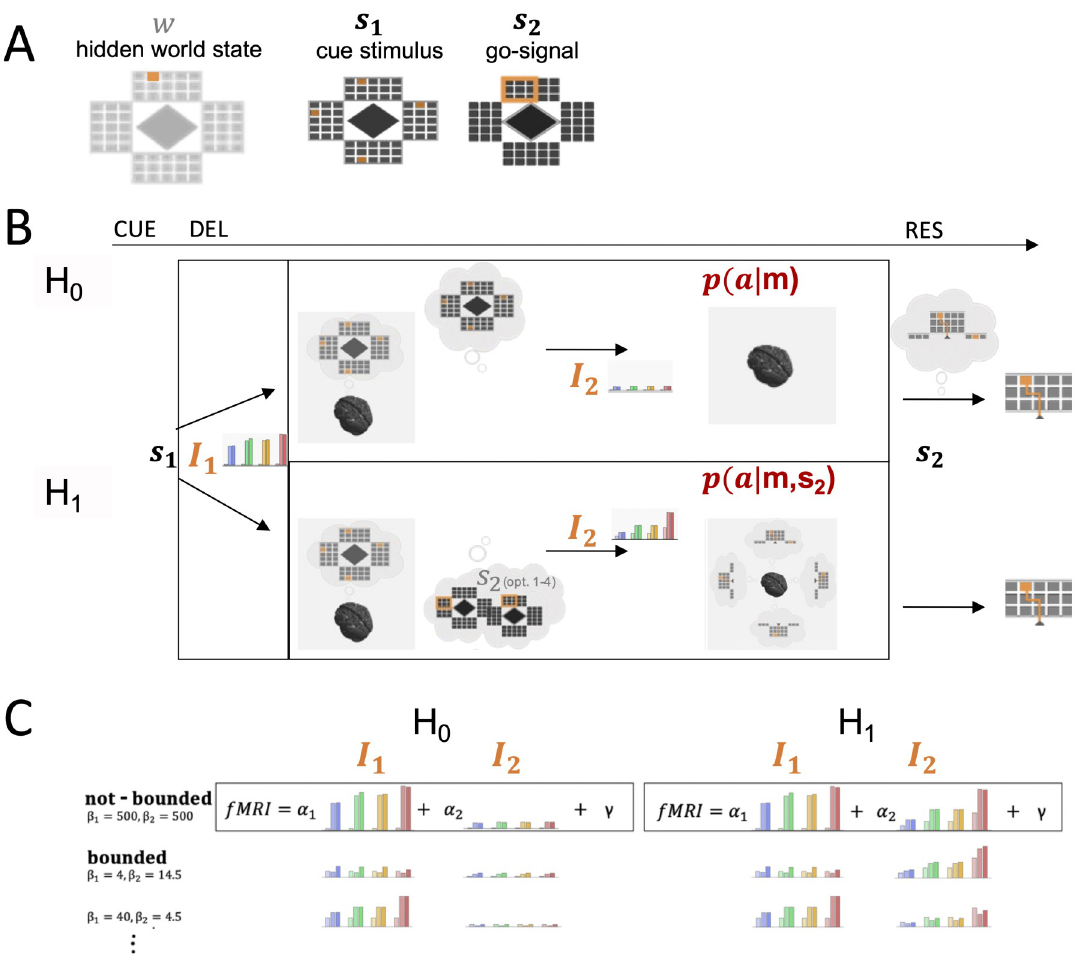
Fig 4. Information theoretic model of planning with information constraints. (A) Information about the hidden world state w 2 W (the exact target location) is revealed in two steps during the experimental trial. The initial cue stimulus s 2 S indicates potential 1 1 target locations while the later go-signal s 2 resolves any remaining uncertainty about the actual hidden target w . (B) When seeing s 1 , the decision-maker can in a first step form a memory m 2 M which is required to infer the world state when seeing s 2 after the delay and, therefore, is then able to appropriately plan and finally select an action a 2 A that corresponds to a movement path representation. Both hypothesis (H 0 and H 1 ) contrast the predicted information I 1 and I 2 in all 12 DRT conditions for a delayed planning strategy and concurrent prospective planning strategy during the delay (DEL). H 0 : During the delay phase only memory m is used to reduce uncertainty about actions. H 1 : Concurrent prospective planning of actions during delay phase requires the anticipation of all possible selection stimuli s 2 and planning movement sequences concurrently. I 2 therefore is higher in H 1 than in H 0 and, moreover, varies more strongly with movement sequence length. (C) Model Comparison. We regressed theoretical memory and prospective planning information with measured fMRI activity in relevant brain areas during the delay phase and tested two hypotheses: H 0 , where information-processing merely requires uncertainty reduction based on memory formation m and H 1 with higher information- processing effort required for prospective planning to anticipate possible future movements. Theoretical information values I 1 and I 2 for different memory and planning capacities, defined by model parameters β 1 and β 2 , were regressed (using regression coefficients α 1 and α 2 ) with the measured fMRI BOLD activity. For lower β 1 and β 2 , memory and planning capacity accordingly is more limited. We regressed the information values for different degrees of boundedness and compared the best model fits with the maximal information values in the case without bounds, where β 1 and β 2 were chosen maximally ( β 1 = 500, β 2 =